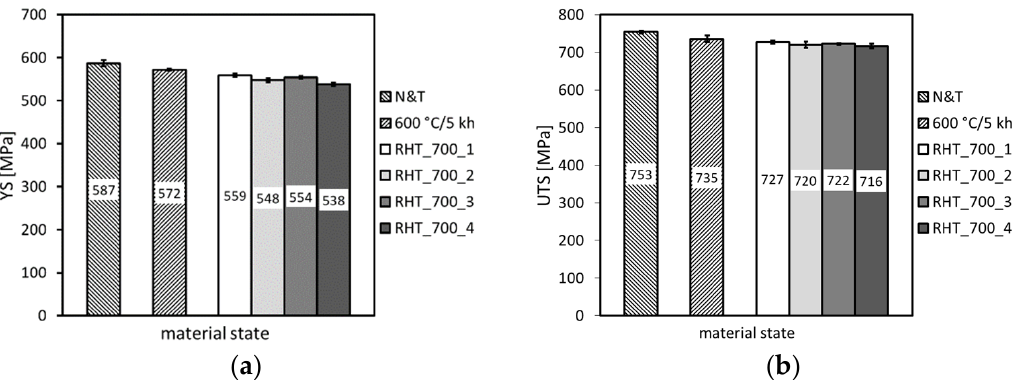
Figure 11. The effect of various heating up and cooling down conditions of the rejuvenation heat treatment at 700 °C for 1 h on ( a ) yield stress and ( b ) ultimate tensile strength.